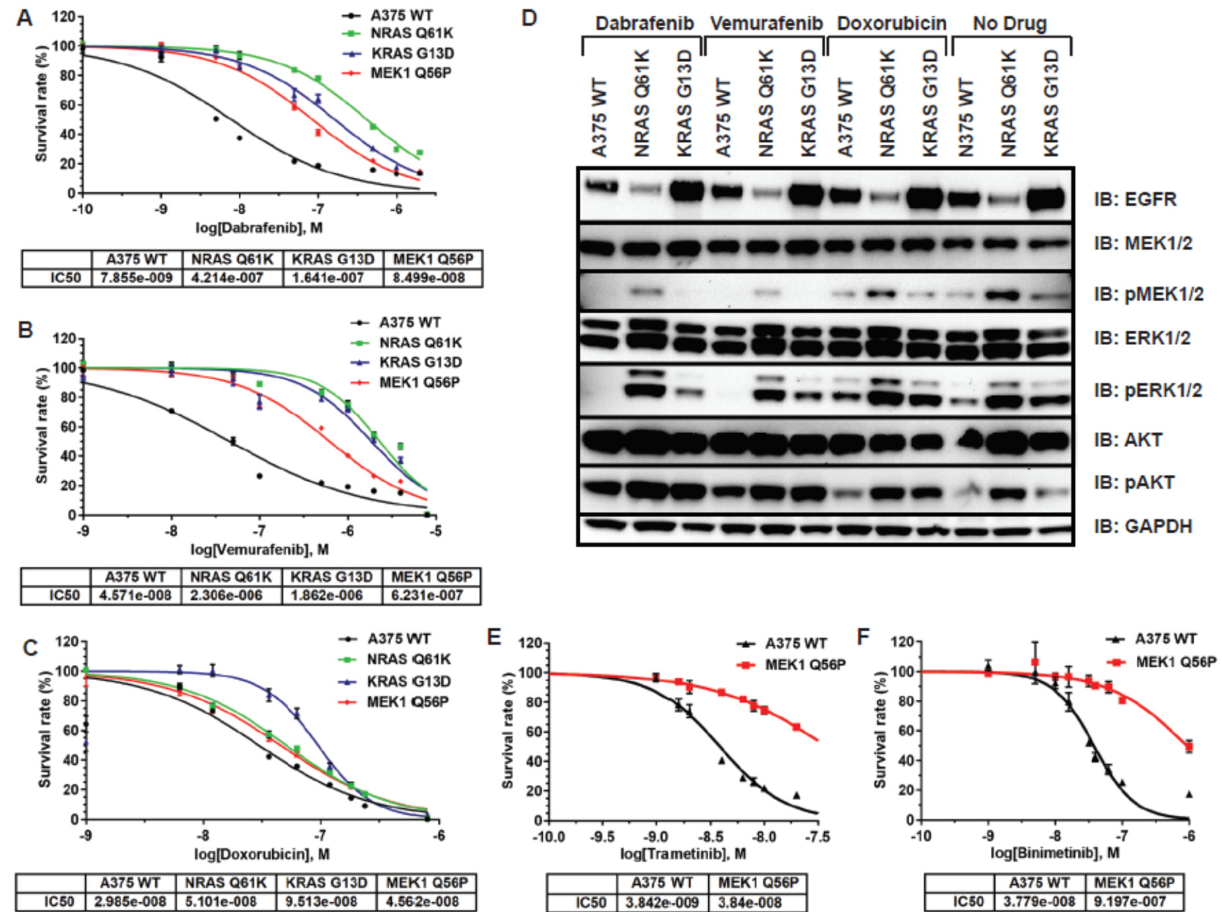
Figure 2. Isogenic melanoma models are resistant to BRAF inhibitors but not to BRAF non-specific chemotherapeutics in 2D tissue culture. ( A ) Dabrafenib resistance of A375 melanoma models in 2D tissue culture; ( B ) Vemurafenib resistance of A375 melanoma models in 2D tissue culture; ( C ) No resis- tance to the BRAF non-specific chemotherapeutic doxorubicin in 2D tissue culture; ( D ) Immunoblot demonstrating BRAF inhibitor resistance in EGFR pathway signaling in NRAS Q61K and KRAS G13D A375 melanoma models. Cells were treated with 1.0 µ M of the indicated drug for 90 min prior to harvesting protein; ( E ) Dose-response curve for the MEK inhibitor trametinib in the MEK1 Q56P melanoma model in 2D tissue culture; ( F ) The same curve as in ( E ) for the MEK inhibitor binimetinib.